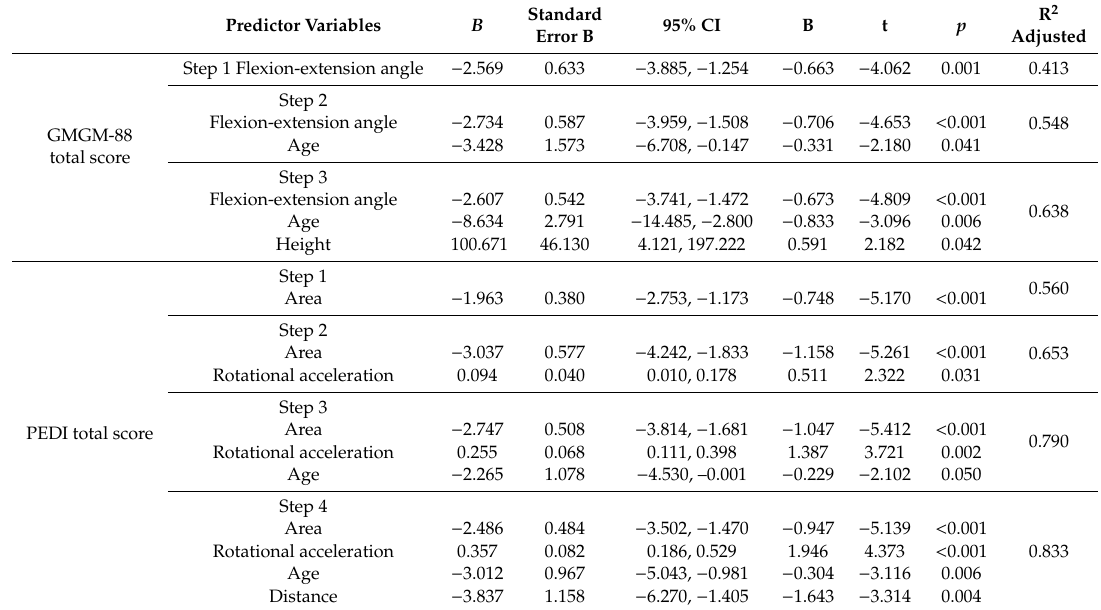
Table 4. Summary of the stepwise regression analyses to determine predictors of functional state (GMFM-88 and PEDI total scores) of CP individuals ( n =